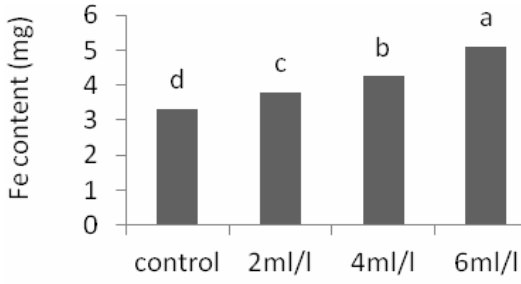
Fig.5. Effect iron application on Fe